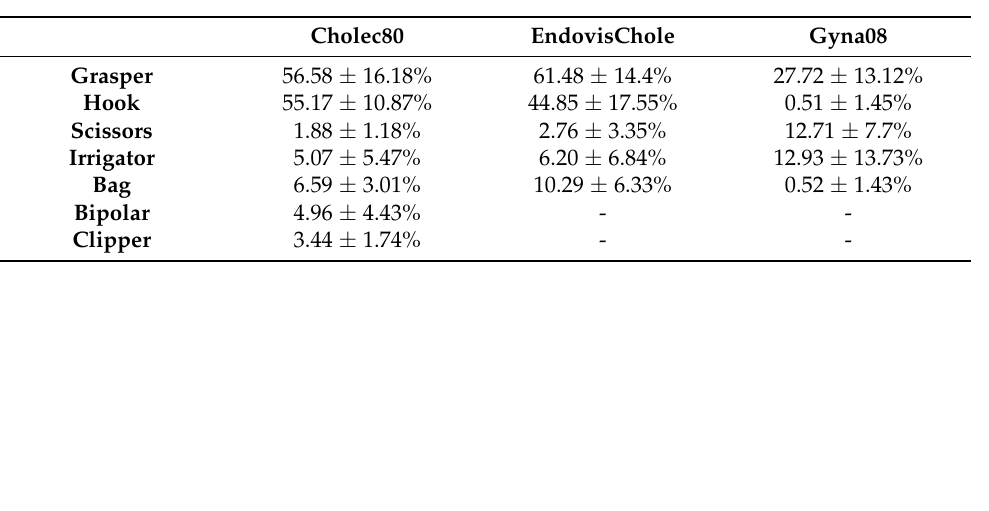
Table 1. Mean and standard deviation of the percentage of tool usage in procedures in the Cholec80, EndovisChole, and Gyna08